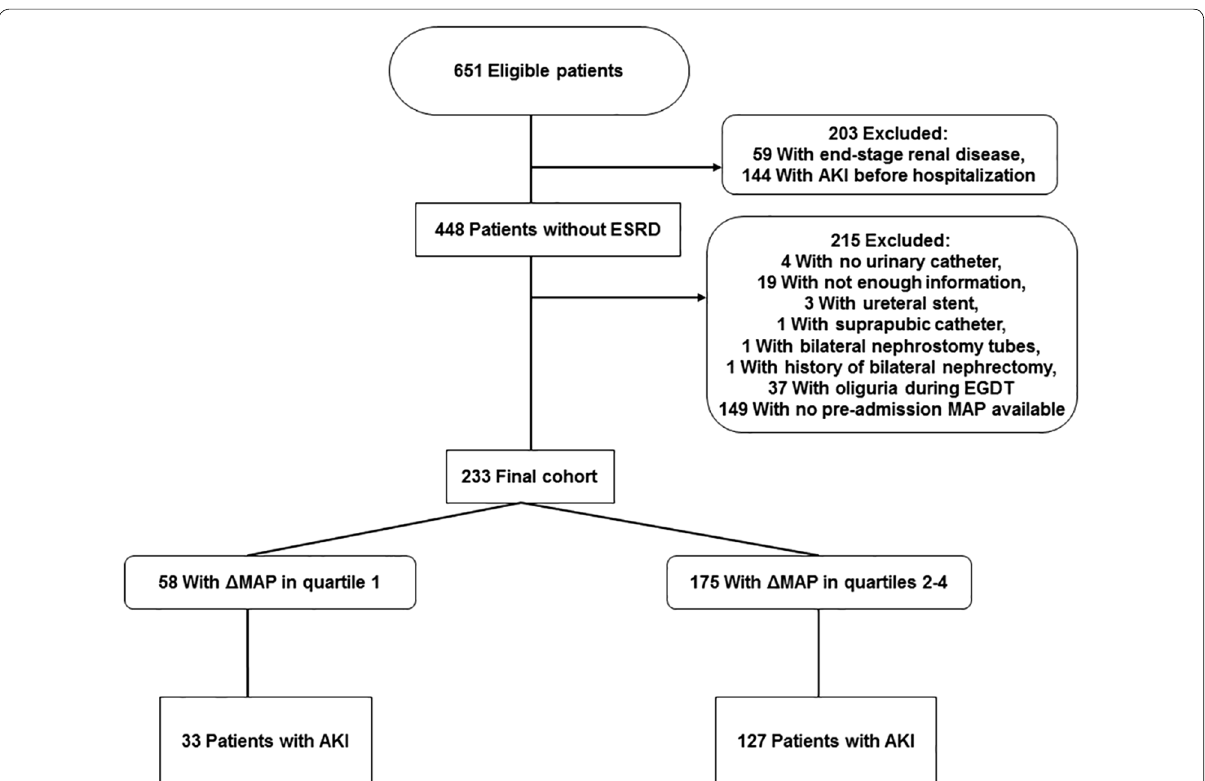
Fig. 1 Flow diagram. The chart shows patient inclusion and exclusion in the study. AKI indicates acute kidney injury; EGDT, early goal-directed therapy; ESRD, end-stage renal disease; MAP, mean arterial pressure; ΔMAP, pre-admission MAP minus the